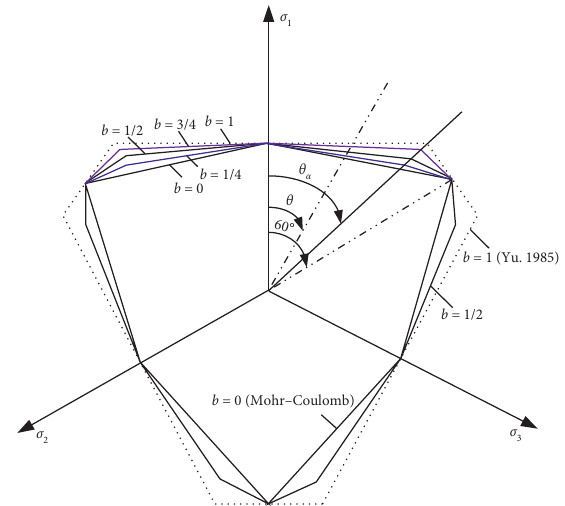
Figure 1: Limiting loci of USC in deviatoric